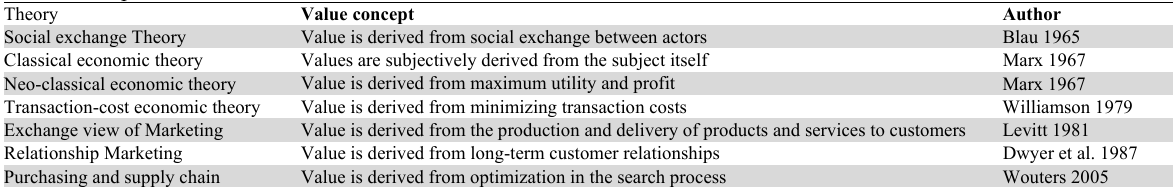
Value concept in the literature